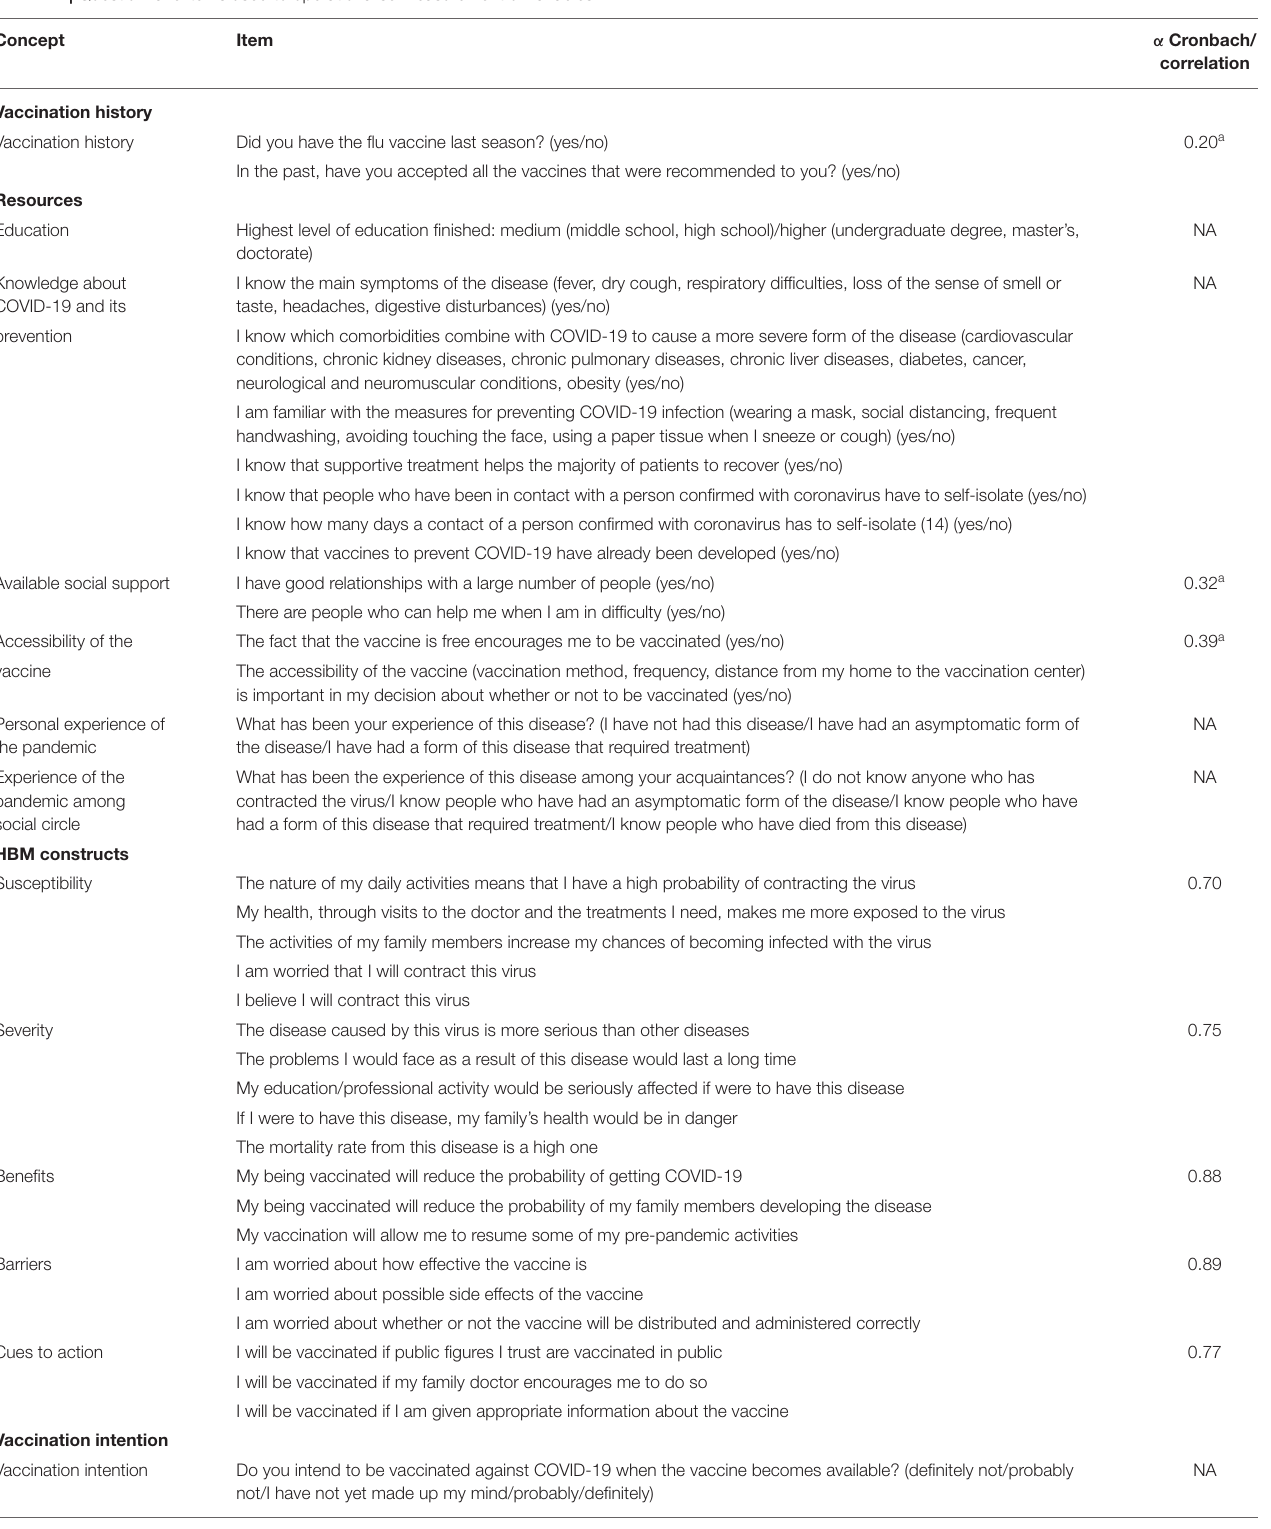
TABLE 1 | Questionnaire items used to operationalise measurement of